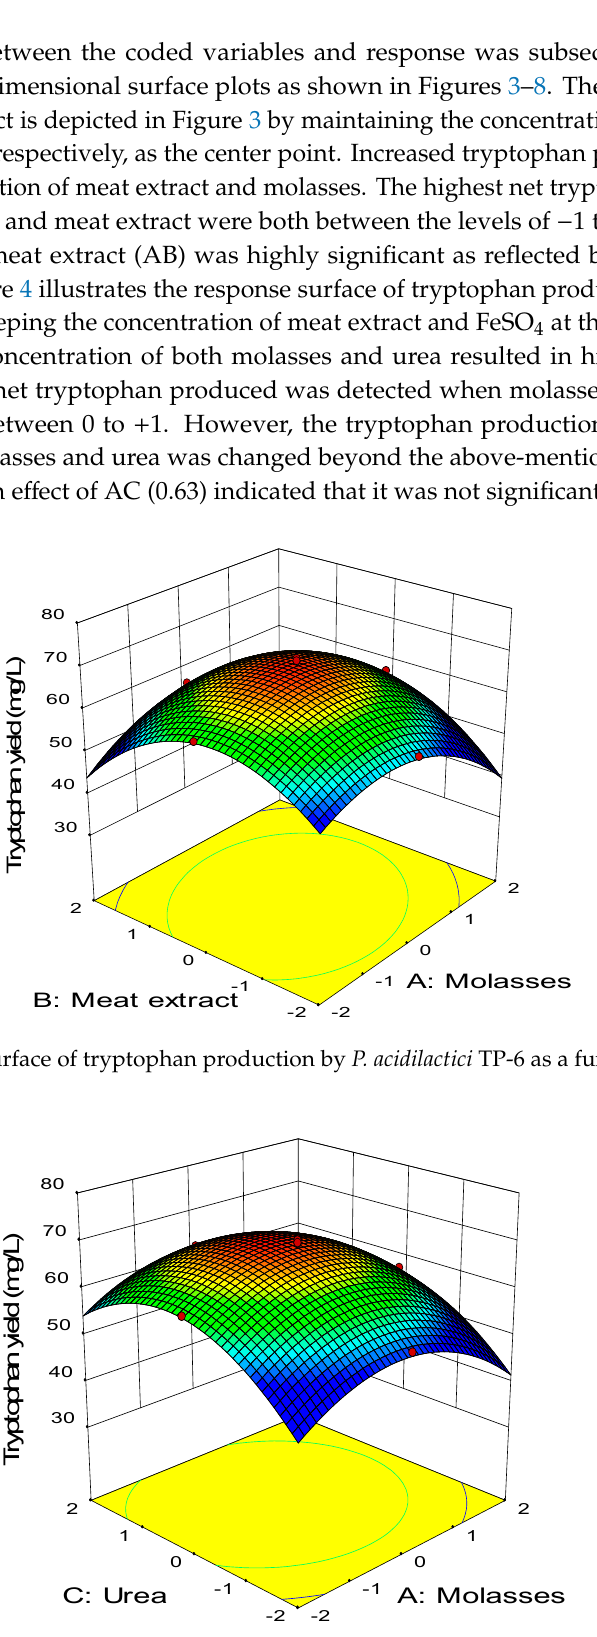
Figure 4. Response surface of tryptophan production by P. acidilactici TP-6 as a function of molasses and urea.